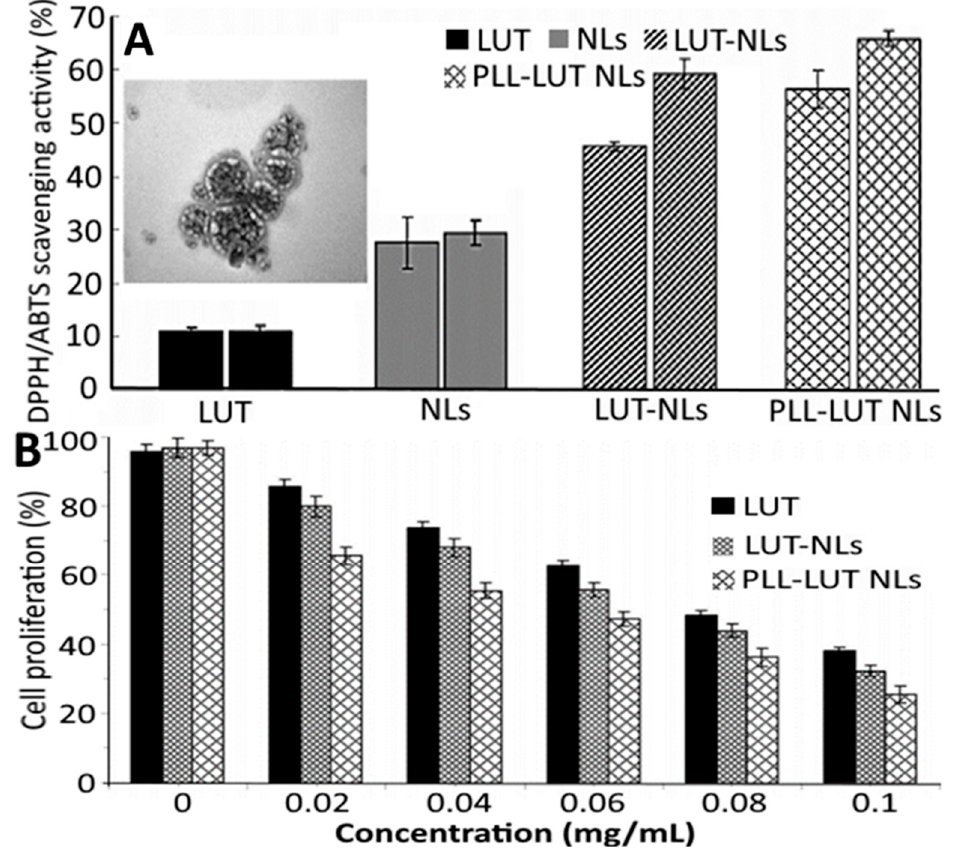
Figure 7. Antioxidant activity in terms of 2,2-diphenyl-1-picrylhydrazyl and 2,2 ′ -azino-bis (3-ethylbenzothiazoline-6-sulfonic acid) scavenging activity for blank nanoliposomes, free lutein, lutein nanoliposomes and poly-L-lysine coated lutein nanoliposomes along with an inset showing the transmission electron microscopic image of poly-L-lysine coated lutein nanoliposomes ( A ) as well as their anti-proliferative effects on Caco-2 colon cancer cell ( B ). The results were expressed as mean ± standard deviation ≥ 3 independent replicates and error bar represents the standard devia- tion from mean values. NLs = nanoliposomes, PLL- poly-L-lysine and LUT = lutein. Adapted with permission from Jiao, et al. [55].